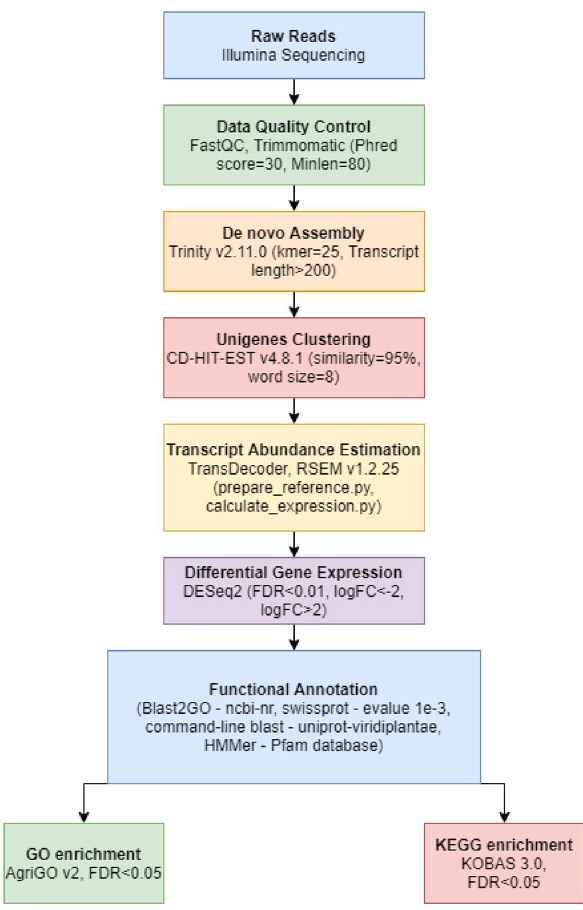
Figure 4. Complete Bioinformatic workflow of RNA-seq analysis involving two genotypes IND99-907 and Co